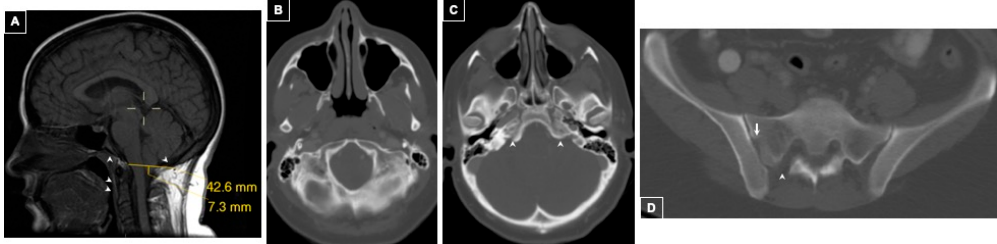
Figure 1. Patient 1 Intracranial and Spinal Imaging. Panel ( A ): Mid-sagittal T1-weighted sequence shows lowest tonsillar position of 7 mm through the foramen magnum. Narrow underdeveloped clivus and occipital bone as well as uncalcified synchondroses of the odontoid are appreciated (arrowheads). Panel ( B ): Axial CT of the head revealed abnormal ossification of the occipital bone. Panel ( C ): Axial CT of the head showing uncalcified petroclival synchondrosis (arrowheads). Panel ( D ): Axial CT of lumbo-sacral spine shows spina bifida occulta of S1 (arrowhead) and segmentation anomaly of the sacral ala (arrow).